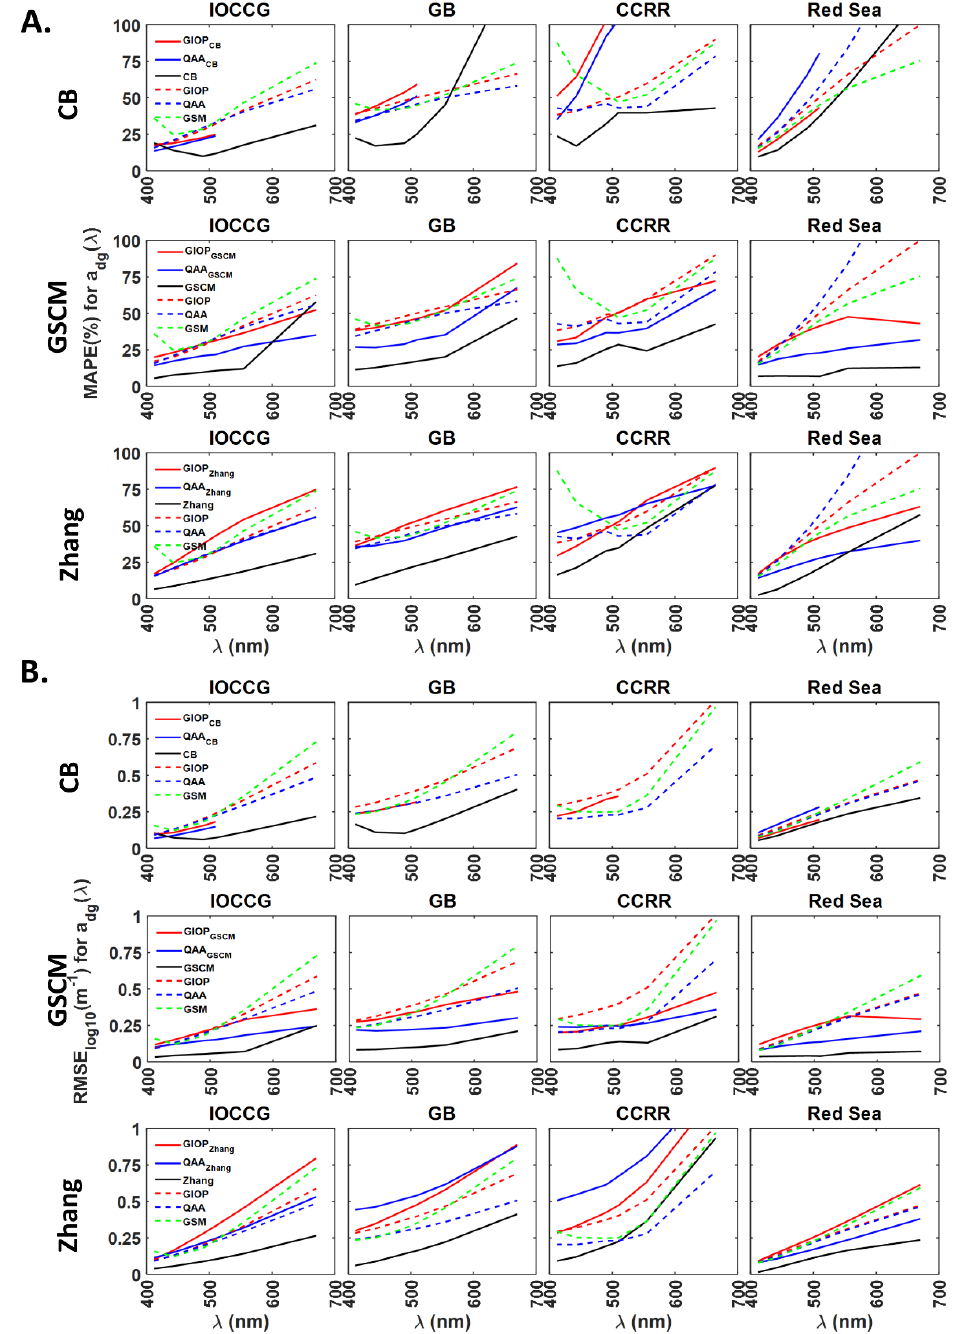
Figure 8. Comparison of GIOP CB , QAA CB , GIOP GSCM , QAA GSCM , GIOP Zhang and QAA Zhang models in deriving a dg ( λ ) from R rs ( λ ) of IOCCG, GB, CCRR and Red Sea datasets using ( A ). MAPE and ( B ). RMSE in log scale. Here, GIOP CB indicates that GIOP algorithm with default configuration is used to derive a nw ( λ ) from R rs ( λ ) of each of the four datasets. In the second step, the GIOP-derived a nw ( λ ) is used as input to CB algorithm to obtain absorption subcomponents of a ph ( λ ) and a dg ( λ ) . The same procedure is used in GIOP Zhang , QAA Zhang , GIOP GSCM and QAA GSCM models. GIOP, QAA and GSM are the existing operational semi-analytical algorithms that use R rs ( λ ) as input and provide absorption subcomponents as outputs. The CB, GSCM and Zhang’s models use spectral non-water absorption coefficient, a nw ( λ ) as input to derive the absorption